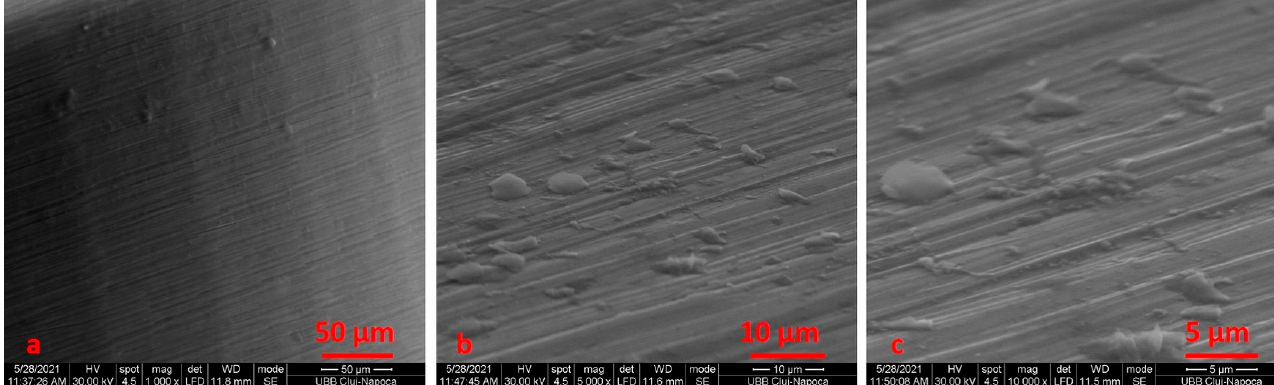
Figure 12. SEM images with mini-implants and PG at ×1000 ( a ), x5000 ( b ), ×10,000 ( c ) magnification. Extensive bacterial colonization ( a,b,c ) on the mini-implant bodies.